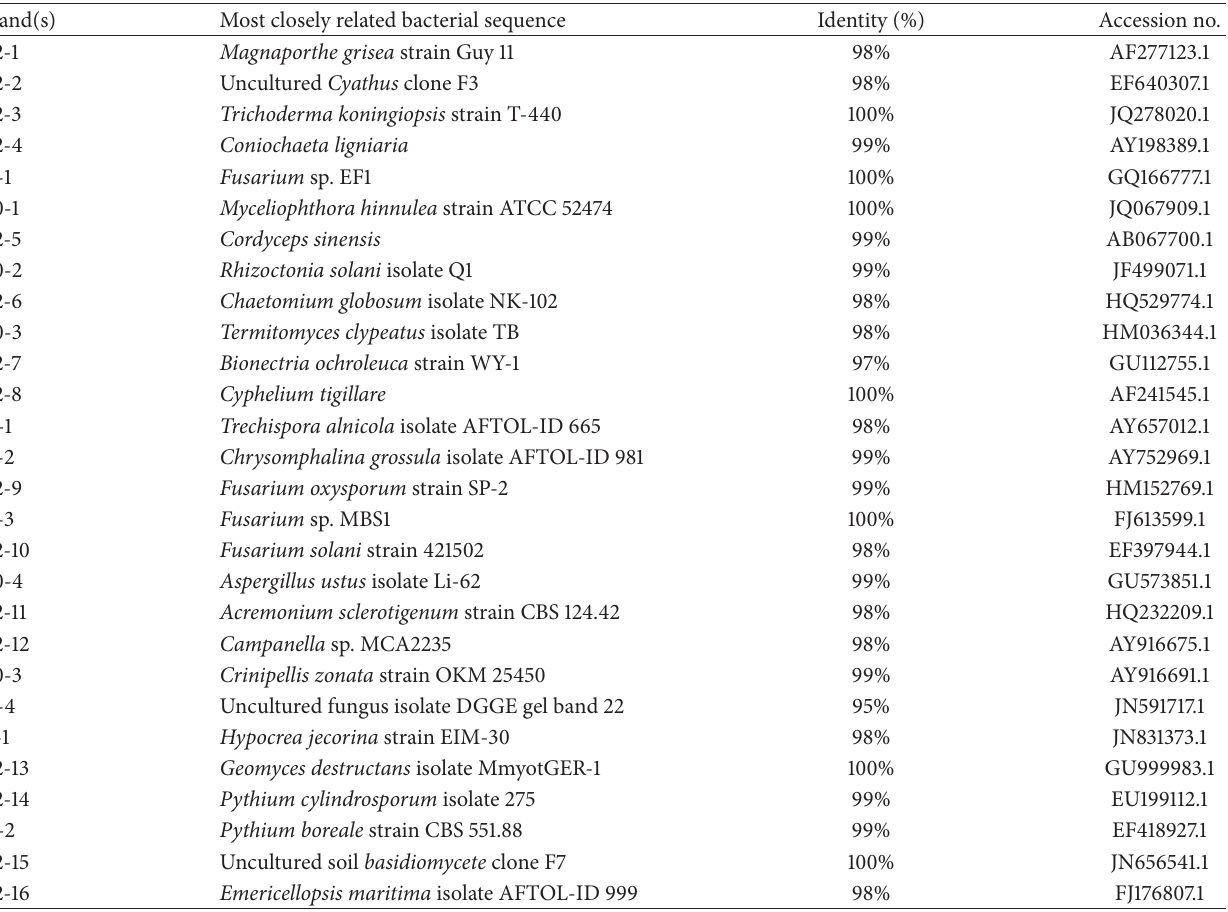
Table 2: Most closely related sequences to those derived from selected 18S rDNA amplicons separated by DGGE.